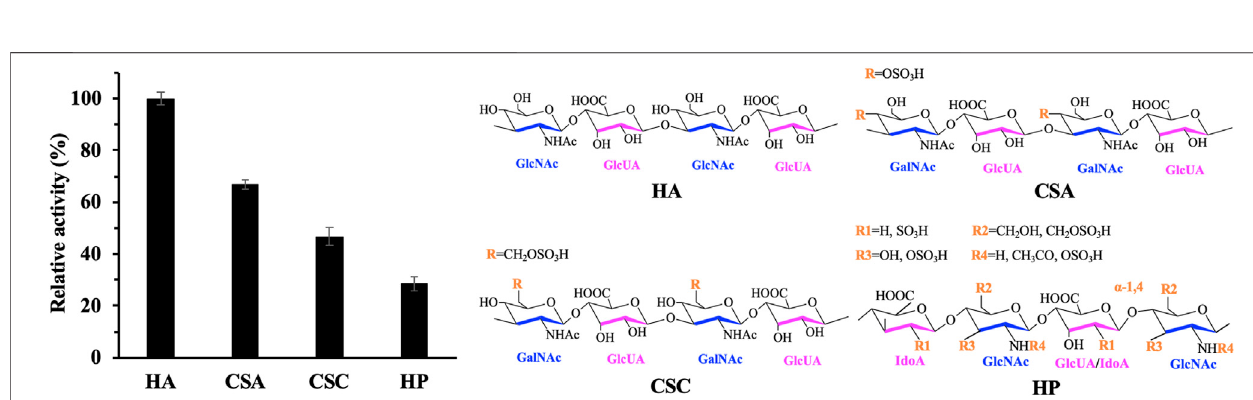
FIGURE 4 | Hydrolysis activity of recombinant hPH20 on different glycosaminoglycan substrates.